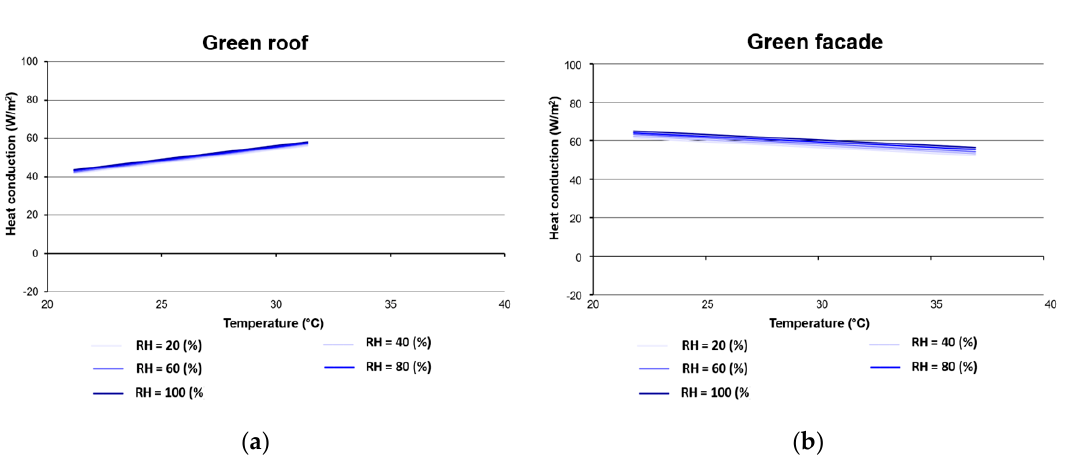
Figure 11. Sensitivity of ( a ) the heat conduction through the green roof and ( b ) the heat reduction through the green façade to relative humidity for solar radiation of 800 W/m 2 and wind speed of 1 m/s. In contrast to the wind velocity, that highly influences the thermal performance of the greenery system. It is important to note that the heat conduction through the green roof and the heat reduction through the green façade are more sensitive with wind speeds over 1.5 m / s.